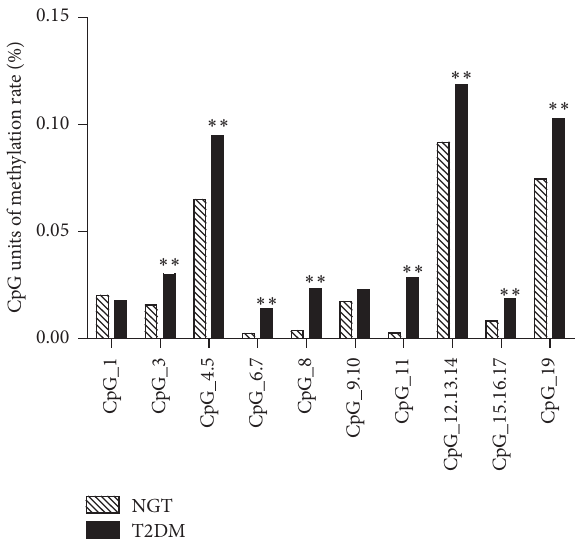
Figure 5: Analysis of the methylation status of FOSL2 in the T2DM andNGTgroups.DNAmethylationchangesof FOSL2 inT2DMand NGT groups. Eight CpG units for DNA methylation in the FOSL2 promoter showed higher methylation in T2DM group. ∗∗ 𝑃 < 0.01 .